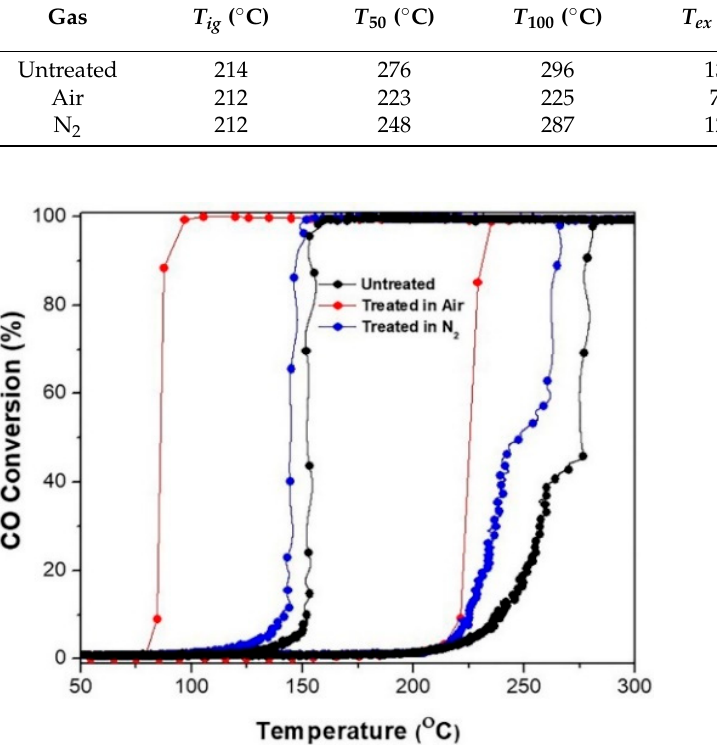
Figure 4. Comparison between the catalytic activity curves of Pd/SiO 2 aerogel catalysts annealed in different atmospheres during ignition and extinction.